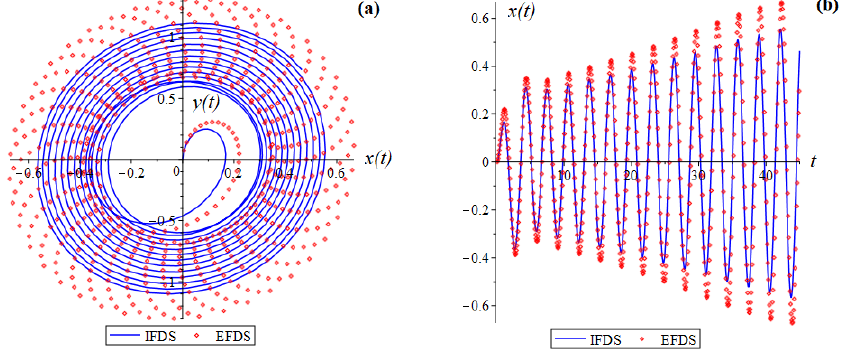
Figure 12. Phase trajectory ( a ) and waveform ( b ) for the Cauchy problem (1) obtained by explicit (7) and implicit (8) schemes.